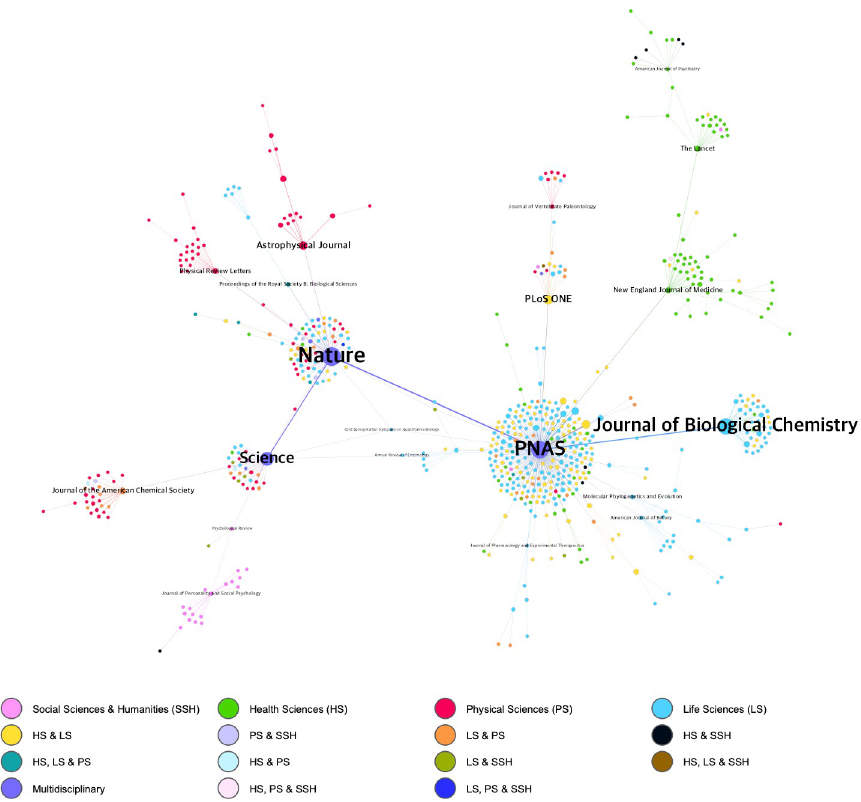
Fig 7. Co-citation network of journals based on Wikipedia article references. This network is produced by applying the Pathfinder algorithm—based on a minimum of 50 co-cites—and shows a total of 629 relationships. Each node represents one journal and node size corresponds to the total number of citations received; color corresponds to the area or combination of subject areas to which it belongs; and the thickness of the edges corresponds to the degree of co-citation between the two. The titles of the 20 journals with the highest intermediation value have been included.